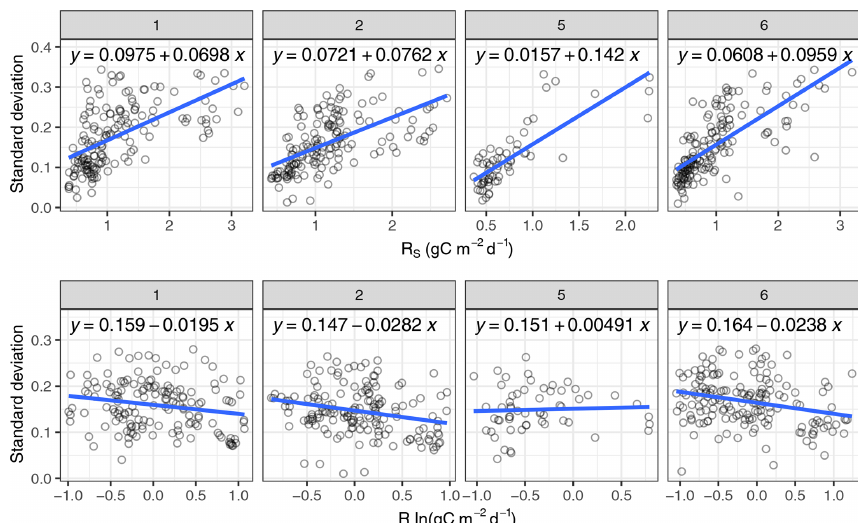
Figure 2. On the original scale the error magnitude (standard deviation of error terms across days) scales with flux magnitude (top). Log transformation avoids this problem (bottom). Columns correspond to different